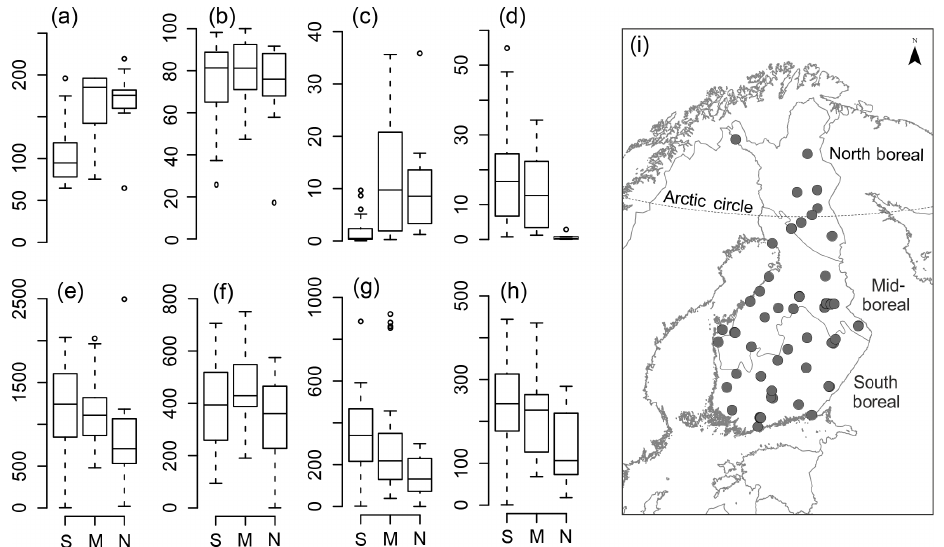
Figure 1. (a) Maximum snow water equivalent ( S SWE , mm), (b) percentage of forest (%), (c) percentage of pristine peatlands (%), (d) per- centage of agricultural areas (%), (e) total tree root biomass (10kgha − 1 ), (f) pine root biomass (10kgha − 1 ), (g) spruce root biomass (10kgha − 1 ) and (h) deciduous root biomass (10kgha − 1 ) at different ecoregions (S is south boreal, M is mid-boreal and N is north boreal).